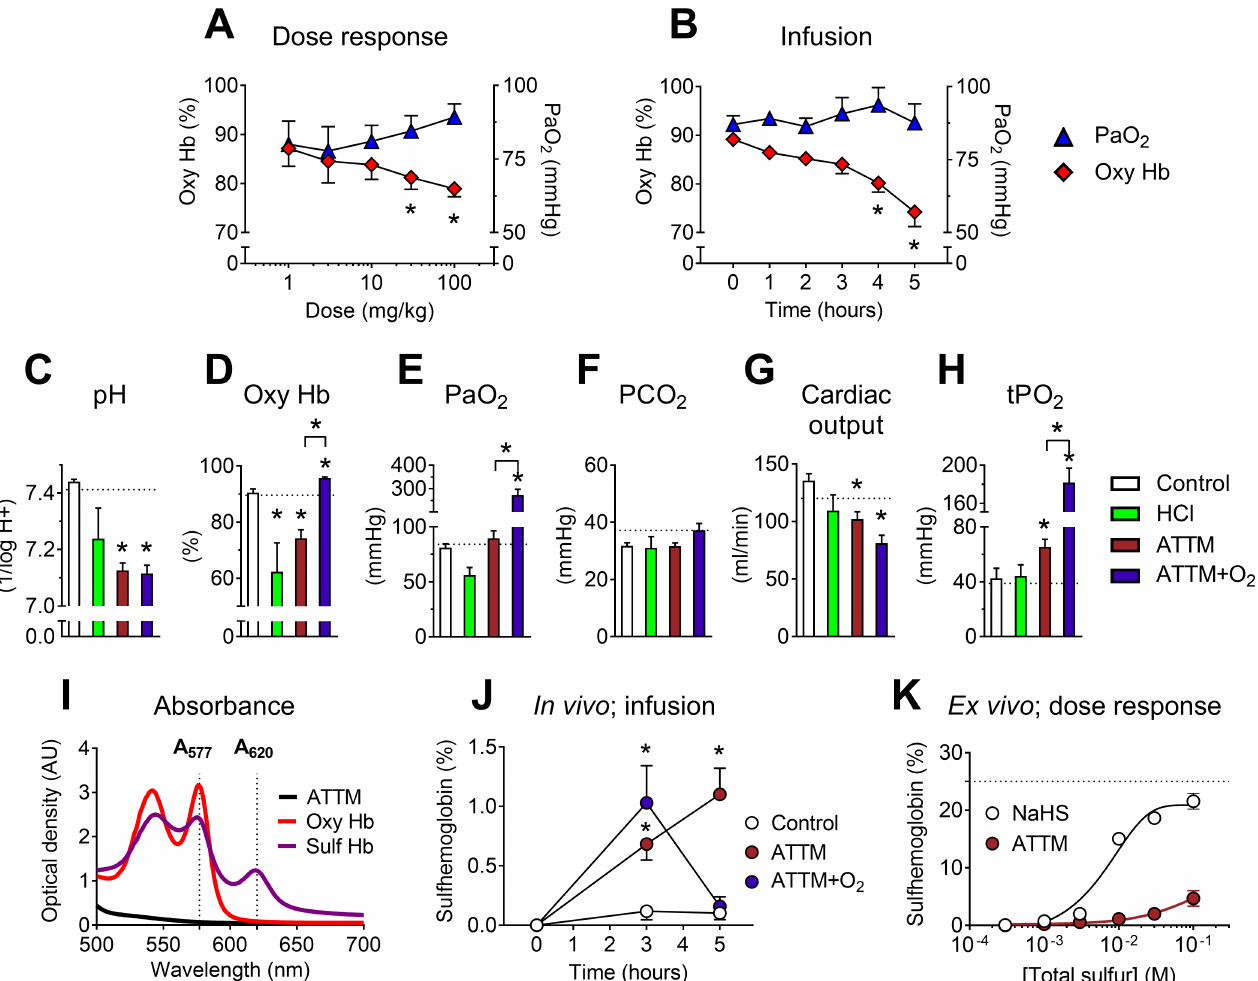
Fig 4. Safety studies. Effects of ammoniumtetrathiomolybdate (ATTM) via either IV bolus dosing (A) or continuous infusion(B) on the arterial partial pressure of oxygen (PaO 2 ) and percentage of oxygenatedhemoglobin (oxy Hb). For the continuous infusionstudy, changesin acid/base balance, hemodynamics, and muscle tissue oxygen tension (tPO 2 ) at experiment end (5 h) are shown in (C–H); dotted lines denote the average baselinevalue. Where applicable,supplemental oxygen was commencedfrom 3 h. (I) shows the absorbance spectrum of oxy- and sulfhemoglobin, used for calculationof sulfhemoglobin levels in vivo (in J; infusion study). Note that there was no absorbance overlapbetween either hemoglobin form and ATTM (1 mM) at λ 577/620. Formation of sulfhemoglobin ex vivo using either ATTM or NaHS to spike na ï verat blood is shown in (K). Here, the dotted line represents the maximum sulfhemoglobin level. * p < 0.05 versus baseline(i.e., before the addition of ATTM) in panelsA, B, and J using a two-way ANOVA followedby Bonferroni’s testing; * p < 0.05 versus control (and ATTM versus ATTM + O 2 ) in panelsC–H using a one-way ANOVA followedby Dunn’smultiplecomparisontest. n = 5–10 (in vivo), and n = 3 per group (ex vivo) in (K).